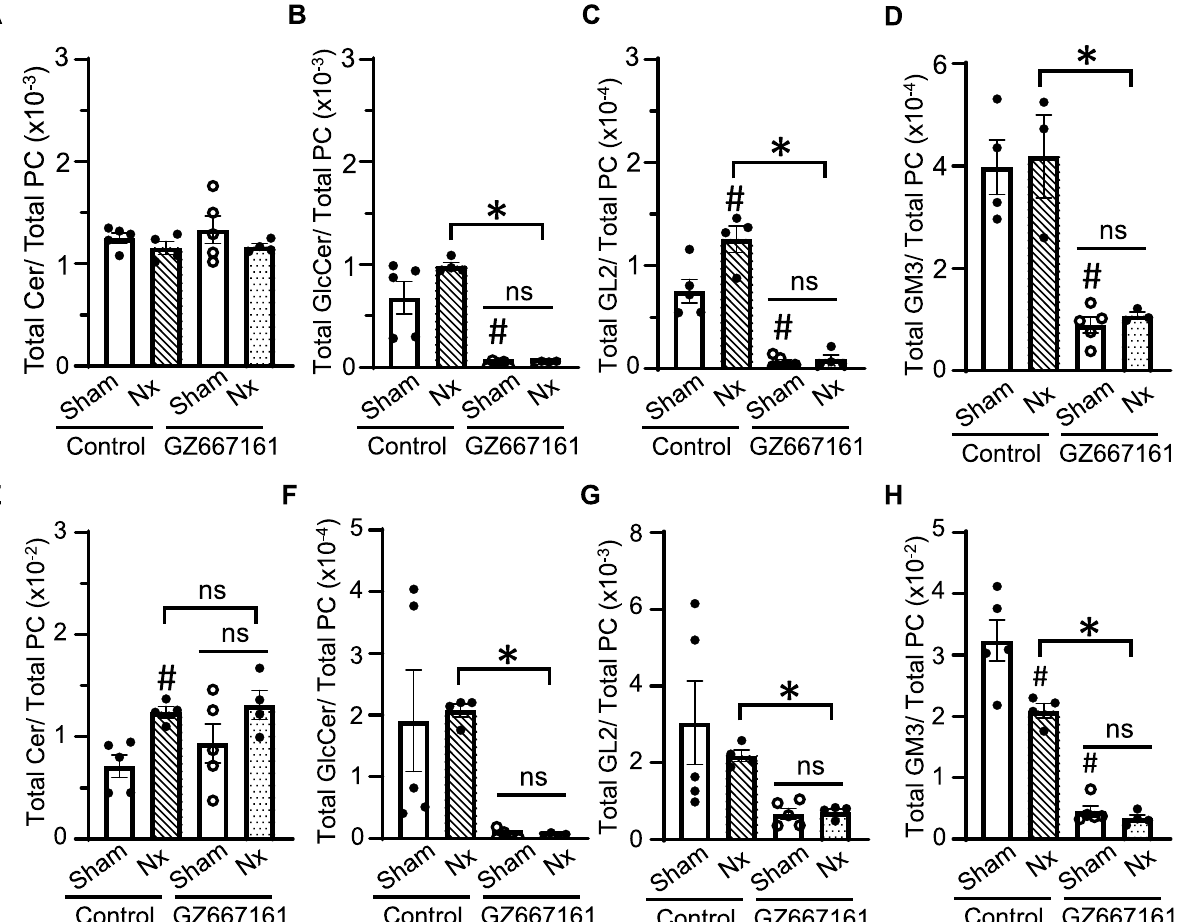
Figure 7. Reduced dose GZ667161 decreases GSL levels in the heart and plasma of CKD and sham mice. ( A – D ) Total ceramide, glucosylceramide, GL2, and ganglioside GM3 levels normalized to PC in the plasma of sham mice on control diet. ( E – H ) Total ceramide, glucosylceramide, GL2, and ganglioside GM3 levels normalized to PC in heart tissue of sham mice on control diet. Sham (n = 5 per group); 5/6 Nx (n = 4 per group). # P < 0.05 vs. sham control of respective group. * P < 0.05 between indicated groups or sham control. ns not significantly different between indicated groups. Data is expressed as mean ±